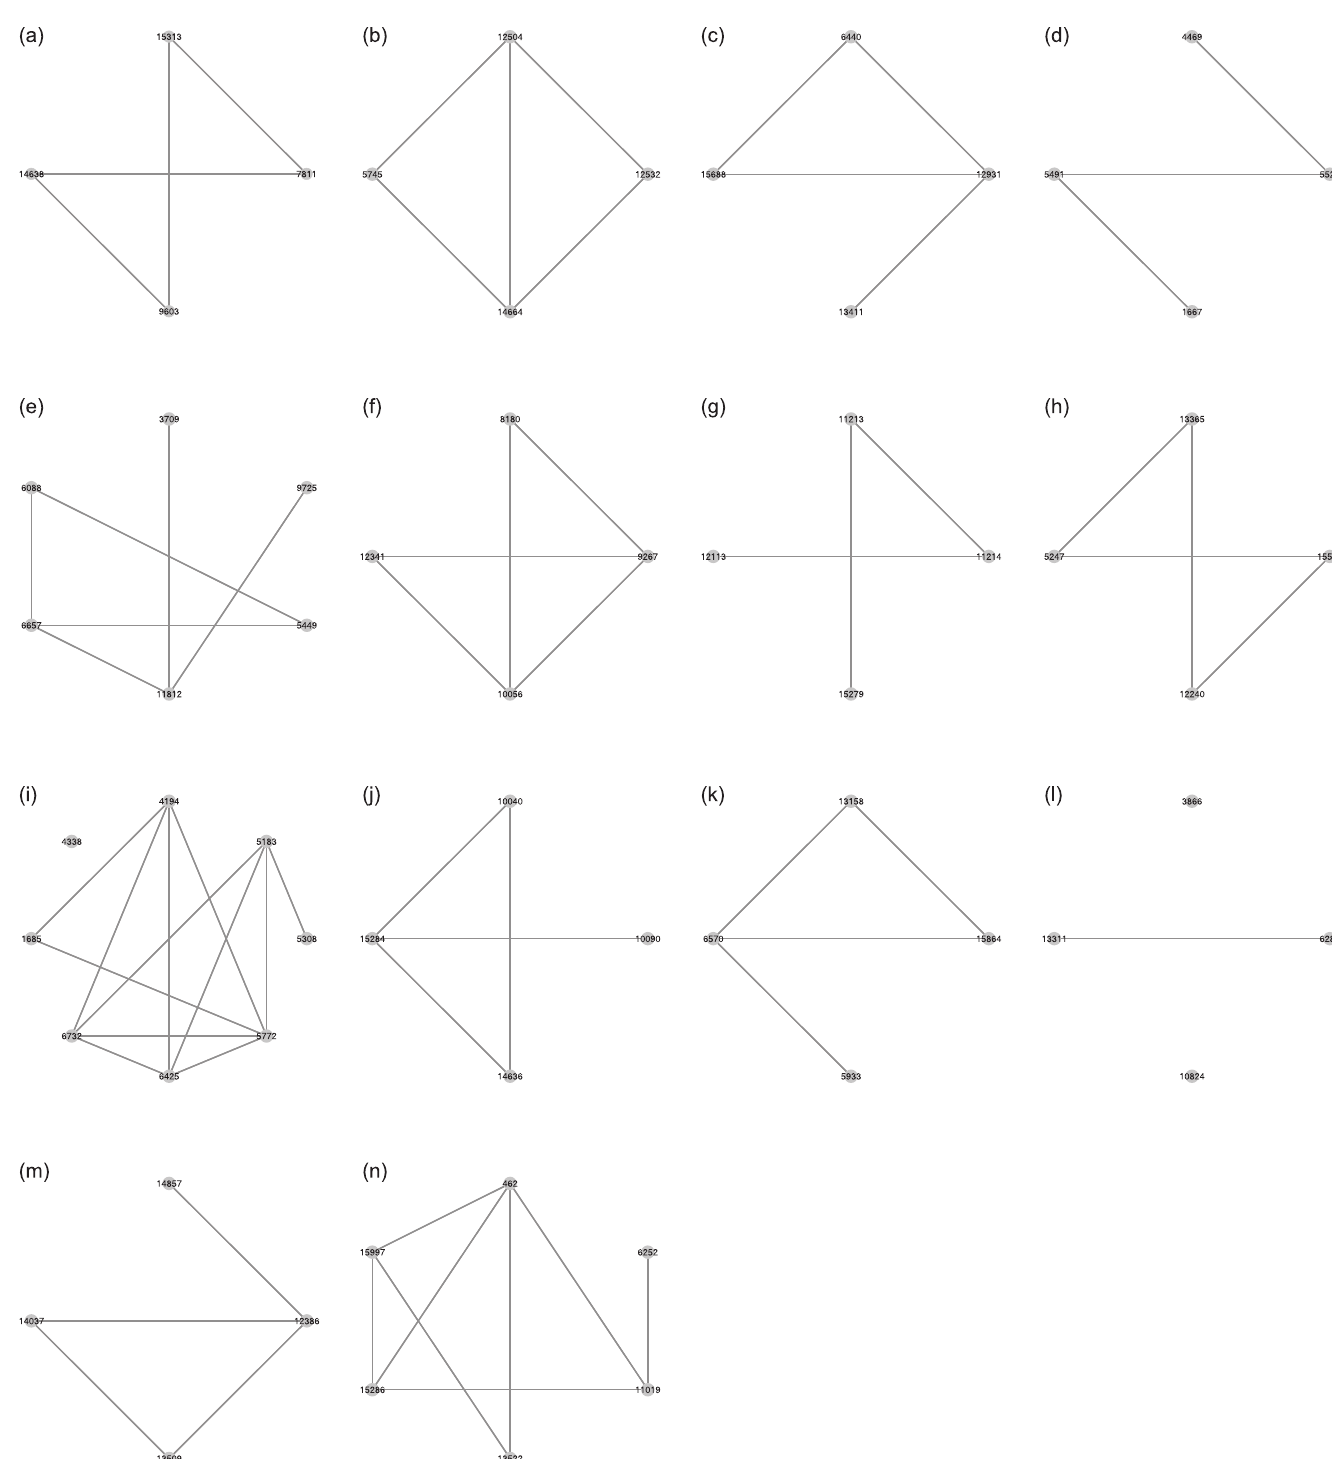
Fig 3. The network structure with selected gene expressions based on different cancers.